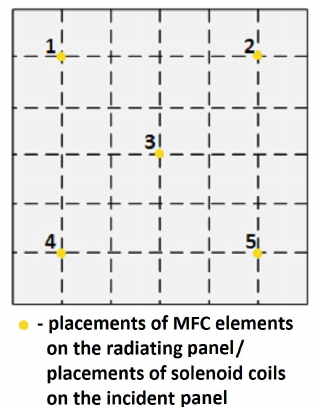
Figure 4. The schematic representation of the MFCs and solenoids placements on the radiating panel and the incident panel,